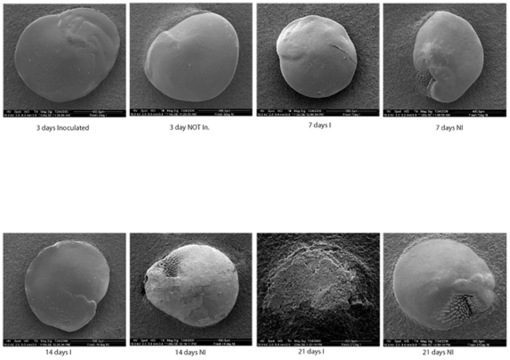
Representative electron micrographs of foraminifera shells incubated in inoculated (I) and uninoculated (NI) treatments described above.Note that over the initial 14 days the NI incubated samples show more deterioration than the I samples. This trend is suddenly reversed in the 21 sample. Only one sample per time could be obtained.